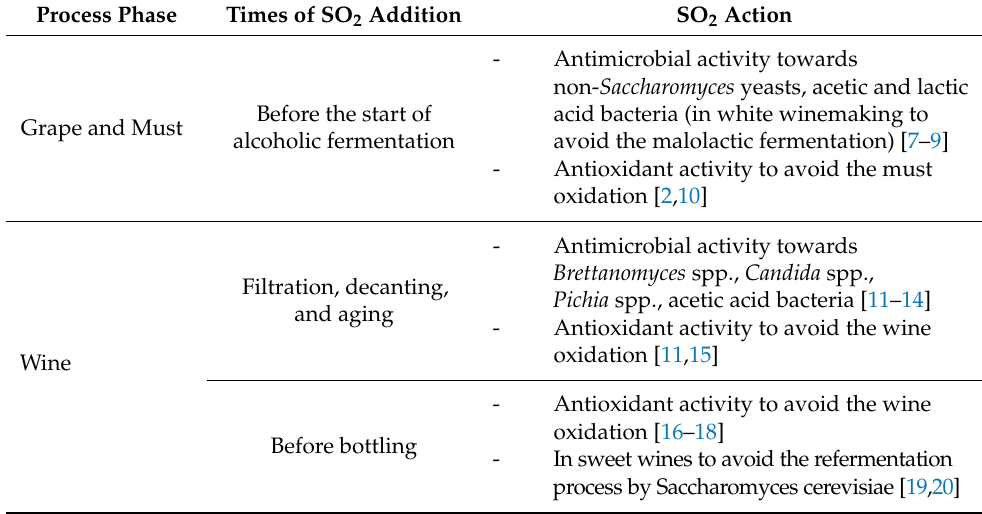
Table 1. Effects of SO 2 addition in grapes, must, and